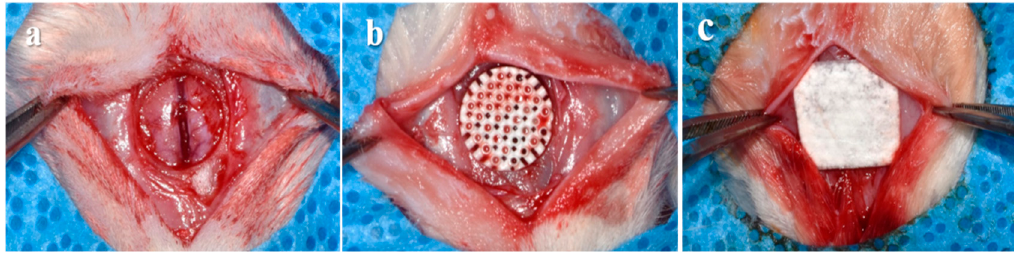
Figure 2. Surgical procedures of this animal experiment. ( a ) Bone defect formation on the cranium. ( b ) Implantation of randomized block bone. ( c ) Placement of collagen membrane.